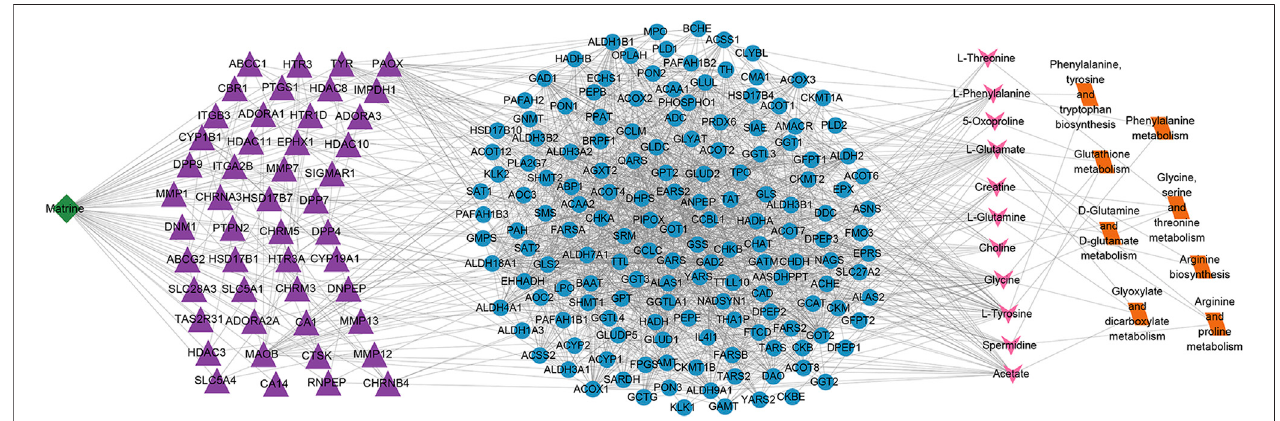
FIGURE 10 | Matrine – targets – metabolic genes – metabolites – metabolic pathways network. The nodes of matrine, vital targets, metabolic genes, metabolites, and metabolic pathways were presented in green, purple, blue, pink, and orange, respectively.